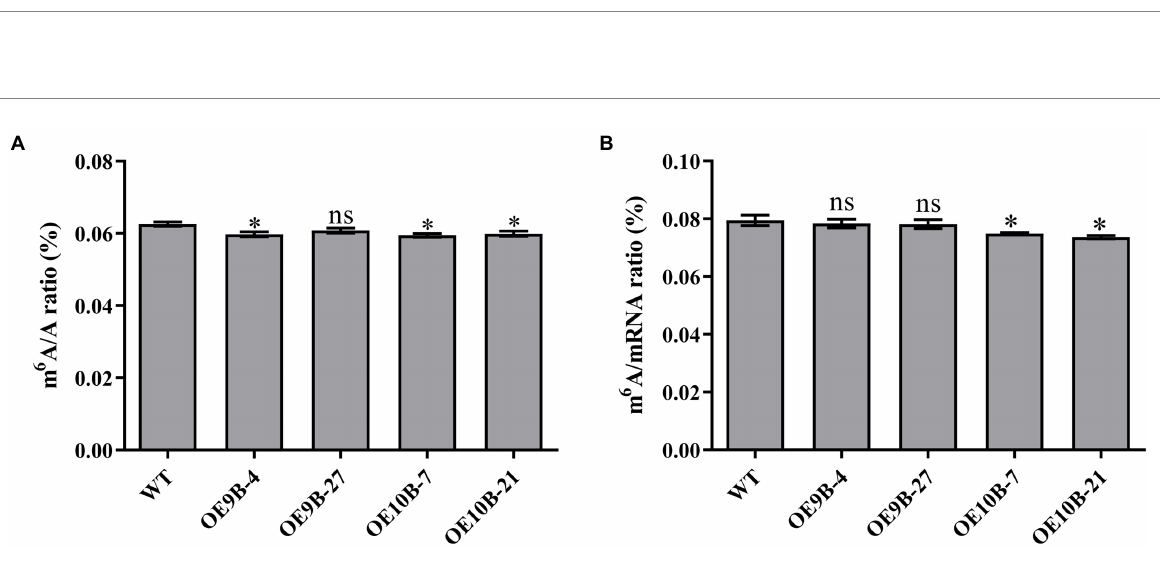
FIGURE 4 N 6 -methyladenosine (m 6 A) RNA methylation level. (A) Global N 6 -methyladenosine (m 6 A) RNA methylation level in WT and transgenic lines under normal conditions. (B) N 6 -methyladenosine (m 6 A) RNA methylation level on mRNA in WT and transgenic lines under normal conditions. At least six 84K poplars were collected as a replicate. The asterisks indicated significant differences between WT and transgenic plants ( * p <